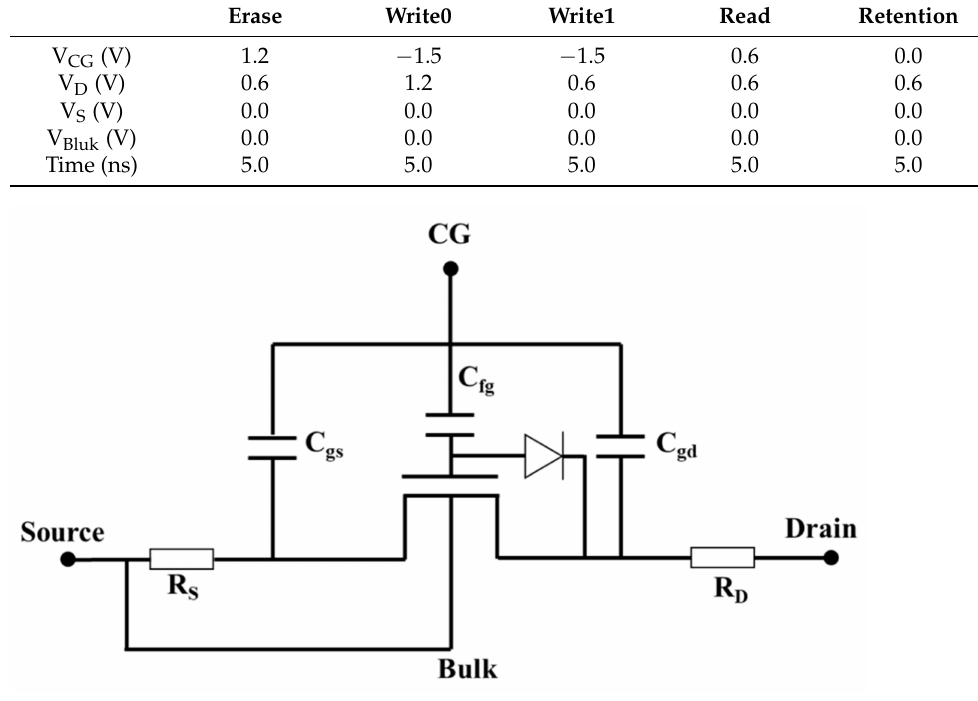
Figure 3. The equivalent circuit of this device.